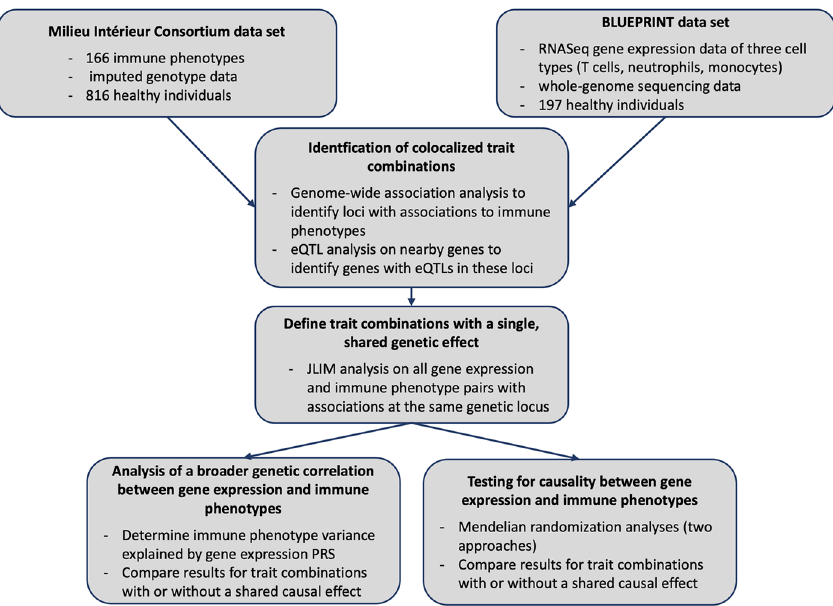
Fig. 5 Overview of the analysis pipeline steps. We compared 164 distinct immune cell phenotypes from the Milieu Intérieur project to gene expression traits in monocytes, neutrophils and T cells from the BLUEPRINT consortium. We fi rst selected pairs of immune traits and gene expression traits with associations at the same genetic locus, and then identi fi ed which trait pairs share a genetic association and which are associated with different genetic variants in close proximity. Using polygenic risk scores (PRS) we then found that trait pairs with shared genetic associations are more likely to share a broader genetic correlation. Additionally, using two different Mendelian randomization approaches we found that trait pairs that share genetic associations are more likely to share a causal relationship. Abbreviations: eQTL = expression quantitative trait locus, JLIM = Joint Likelihood